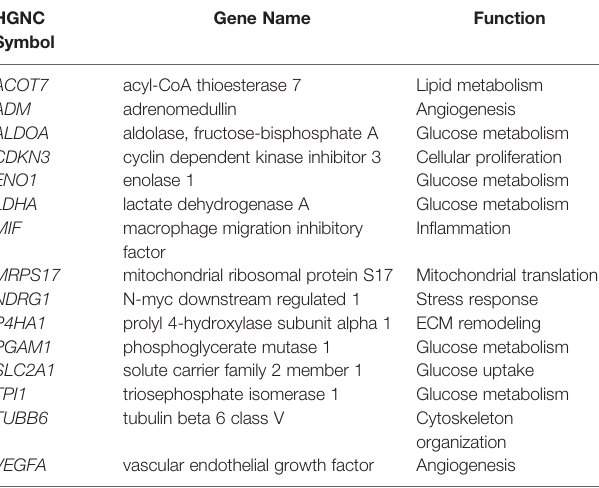
TABLE 2 | 15-gene Buffa hypoxia signature